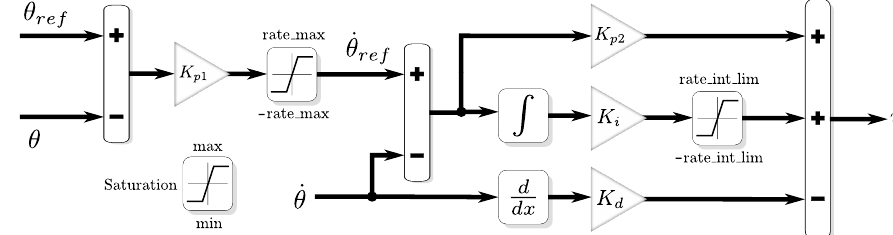
Figure 4. Position and attitude controller structure of a Px4-based UAV [33].